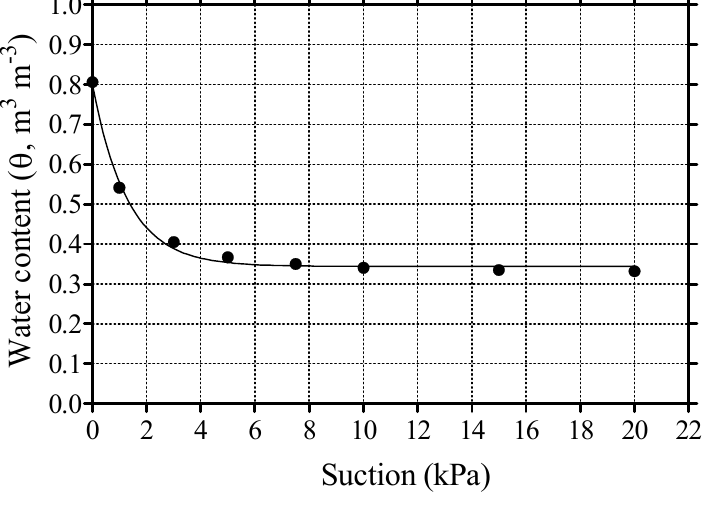
Figure 1. Water retention curve of a peat-pumice mixture, which is widely used for the outdoor production of ornamental nursery stocks in Italy. The determination was conducted in the laboratory following De Boodt’s method [11]. Seven different suctions were applied to the sample: 1.0, 3.0, 5.0, 7.5, 10.0, 15.0 and 20.0 kPa. The value of  at = 0) was estimated from the measurement of porosity saturation (  m